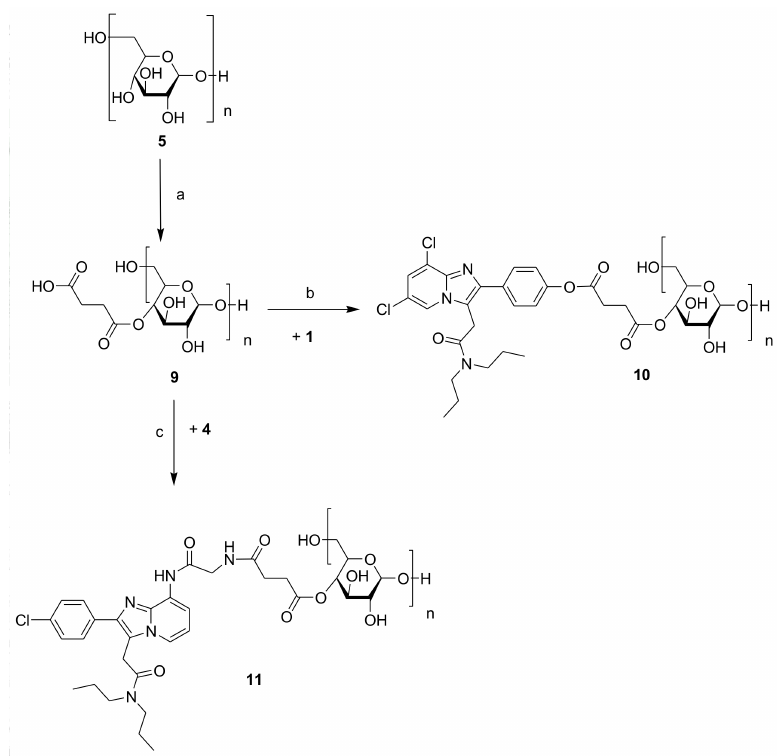
Figure 3. Synthesis of TSPO ligand–dextran conjugates 10 and 11 . Reagents and conditions: (a) Succinic anhydride, LiCl, anhydrous DMF and anhydrous pyridine (10% v / v ), r.t.; (b) EDC, HOBt, TEA and anhydrous DMF, r.t.; (c) CDI, TEA and anhydrous DMF,